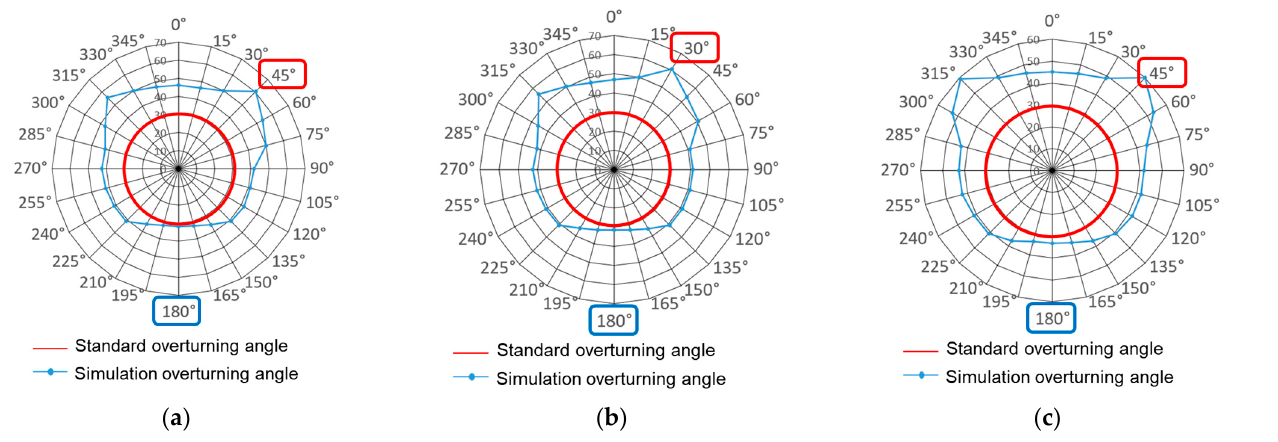
Figure 10. The rollover angles for the attached weights at the front of the radish harvester: ( a ) 50 kg, ( b ) 100 kg, and ( c ) 150 kg.